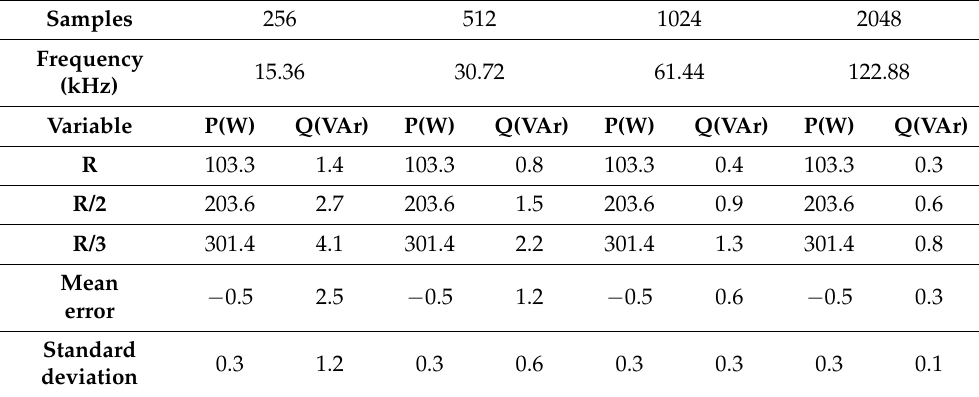
Table 5. CPT powers for resistive loads for 256, 512, 1024 and 2048 samples per cycle.